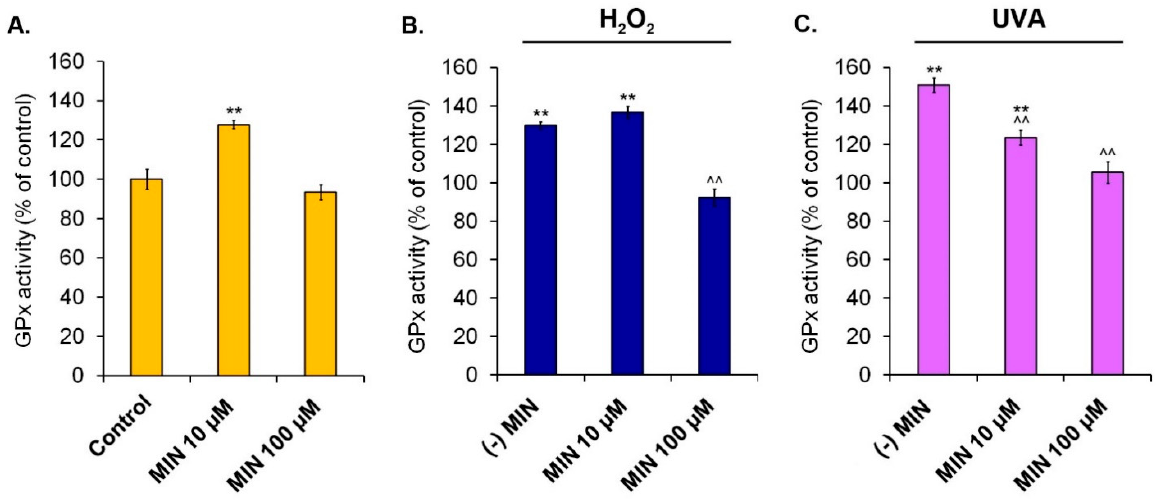
Figure 8. Changes of glutathione peroxidase activity in human normal melanocytes treated with minocycline ( A ) as well as additionally exposed to hydrogen peroxide ( B ) or irradiated with UVA ( C ). ** p < 0.005. vs. control; ˆˆ p < 0.005. vs. (-) MIN.